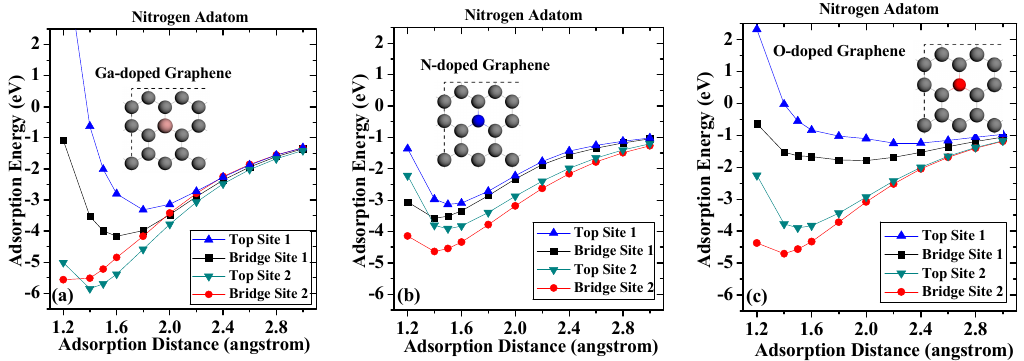
Figure 4. Adsorption energies of nitrogen on ( a ) Ga-doped graphene; ( b ) N-doped graphene; and ( c ) O-doped graphene.